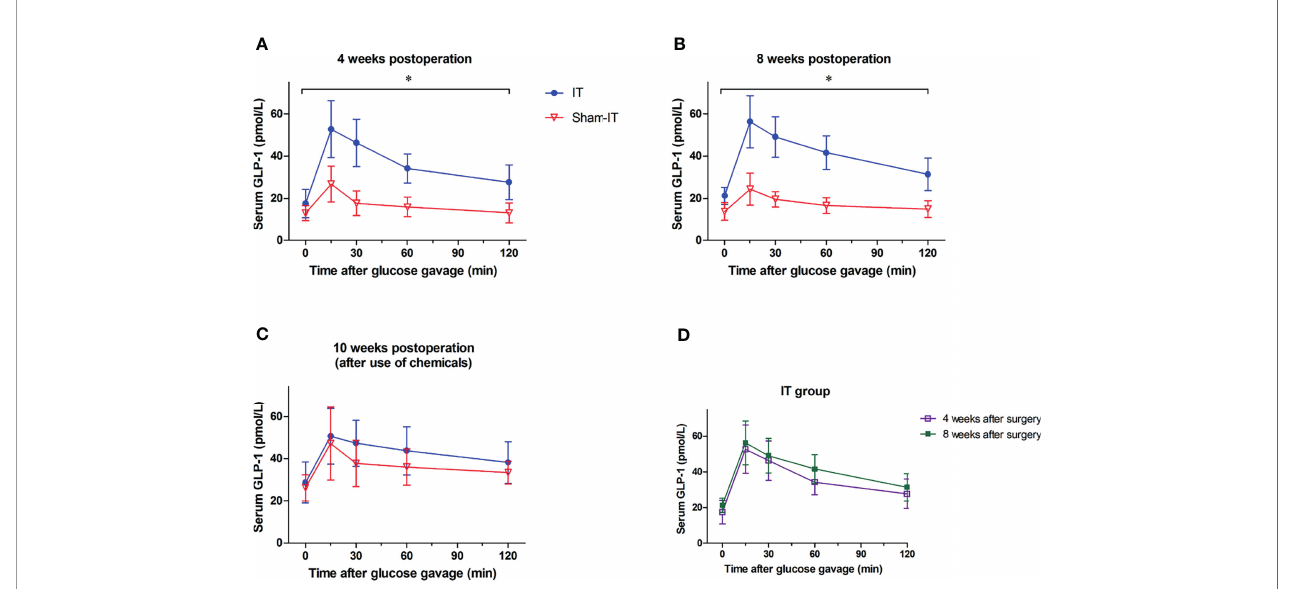
FIGURE 5 | The levels of serum total GLP-1 after surgery. N = 6 in each group. * p < 0.05. (A) Glucose-stimulated GLP-1 levels at postoperative 4 weeks. As compared with sham, GLP-1 level was signi fi cantly higher in IT group at 4 weeks postoperatively (repeated measures ANOVA: p = 0.001 IT vs. sham, p < 0.001 between time points, p < 0.001 of interaction). (B) Glucose-stimulated GLP-1 levels at 8 weeks postoperatively. GLP-1 level was signi fi cantly higher in IT group at postoperative 8 weeks in comparison with sham group (repeated measures ANOVA: p < 0.001 IT vs. sham, p < 0.001 between time points, p < 0.001 of interaction). (C) Glucose-stimulated GLP-1 levels at postoperative week 10. At 10 weeks after operation, because of the use of chemicals, GLP-1 levels were comparable between IT and sham groups (repeated measures ANOVA: p = 0.309 IT vs. sham, p < 0.001 between time points, p = 0.680 of interaction). (D) Glucose-stimulated GLP-1 levels of IT group. GLP-1 concentration at 8 weeks postoperatively was not signi fi cantly higher than that at 4 weeks postoperatively (repeated measures ANOVA: p = 0.358 IT vs. sham, p < 0.001 between time points, p = 0.885 of